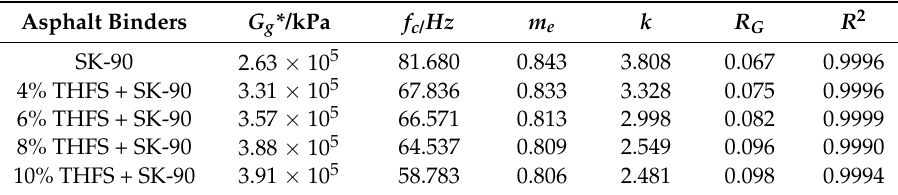
Table 9 lists the fitting parameters of asphalt binders based on the CAM model. Table 9. The fitting parameters based on the CAM